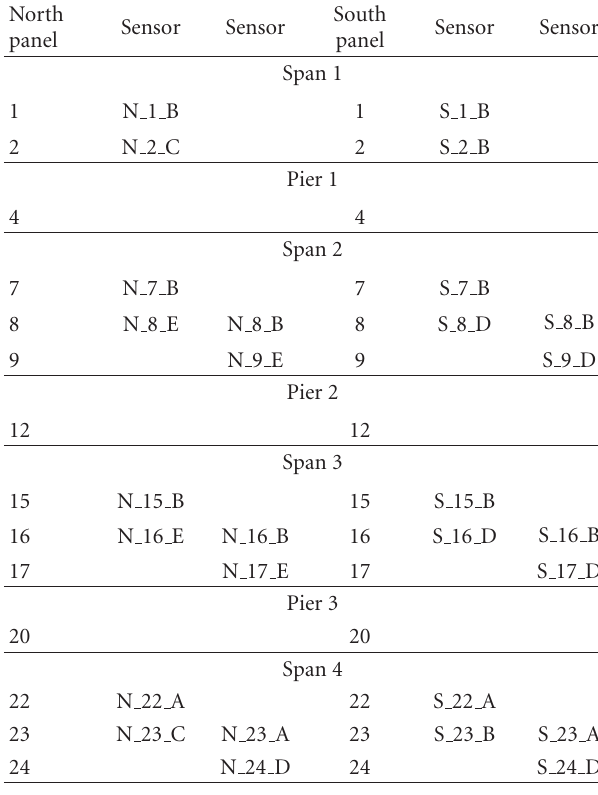
Table 5: Sensors used for stress monitoring along cast-in-place grout (Group